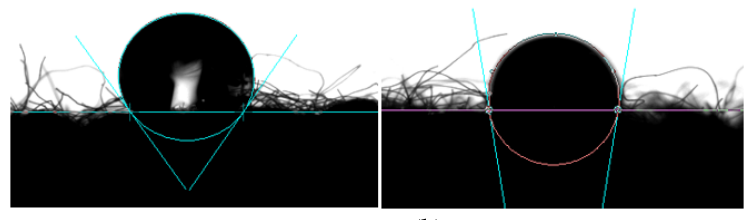
Figure 3. The contact angle of conductive knitted fabrics (( a ) 120.2° for untreated fabric and ( b ) 99.4° for treated fabric).